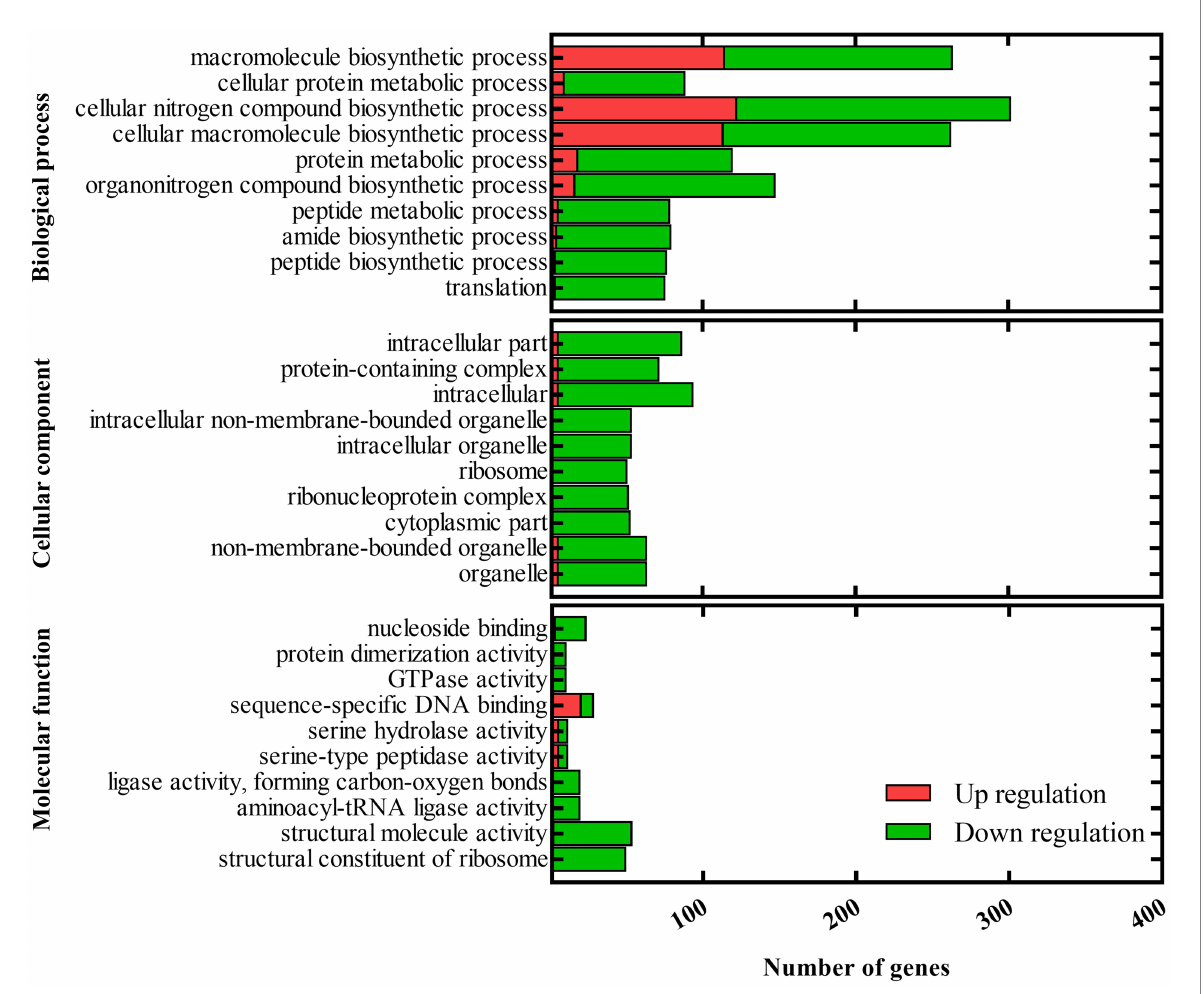
FIGURE 4 Gene ontology (GO) of differentially expressed genes between the barA Ac deletion mutant strain Δ barA Ac and the wild-type strain Aac5. GO analysis takes p < 0.05 as the threshold for significant enrichment. The 30 most significant terms are shown. The horizontal axis is the number of differentially expressed genes, and the vertical axis is the GO